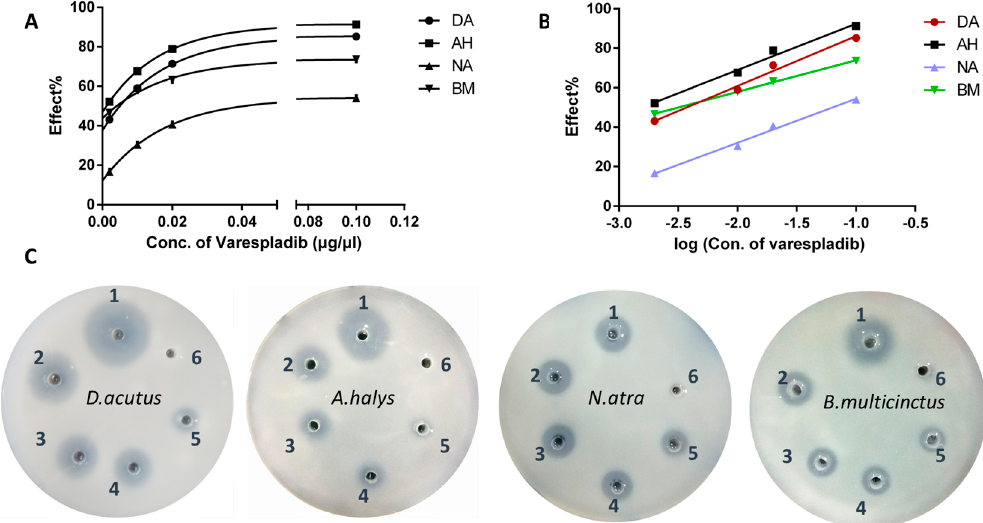
Figure 1. The anti-catalytic effect of varespladib on snake venom phospholipase A 2 in vitro. ( A ) The varespladib concentration versus the inhibitory effect (cut-down area of varespladib group/venom alone); ( B ) the inhibitory effect was linearly proportional to the logarithm of varespladib concentration; and ( C ) the anti-catalytic activities of varespladib to D. acutus , A. halys , N. atra , and B. multicinctus . Well 1 was the positive control, filled with venom alone, well 2–5 were mixtures of venom and 0.1, 0.5, 1, and 5 μ g varespladib. Abbreviations: DA: D. acutus , AH: A. halys , NA: N. atra , and BM: B. multicinctus .